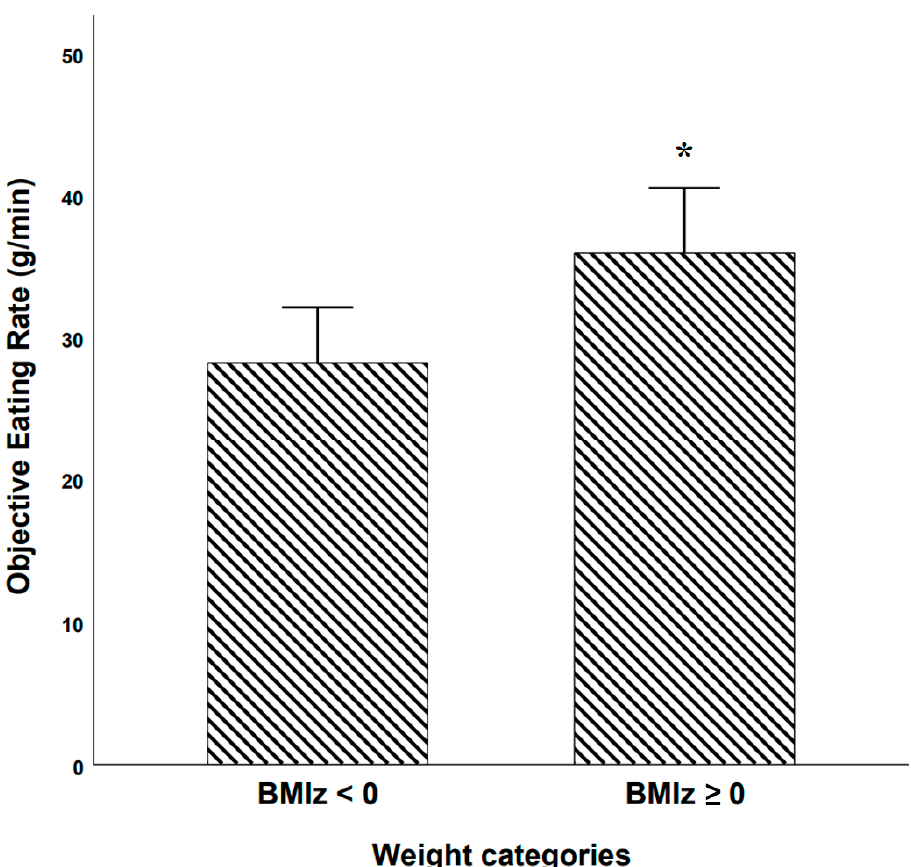
Figure 5. Objective eating rate among students with BMI z-score below 0 ( n = 52) vs. students with BMI z-score equal to or above 0 ( n = 62). * = significantly higher vs. BMI z-score < 0 group. Error bars represents 95% confidence intervals.